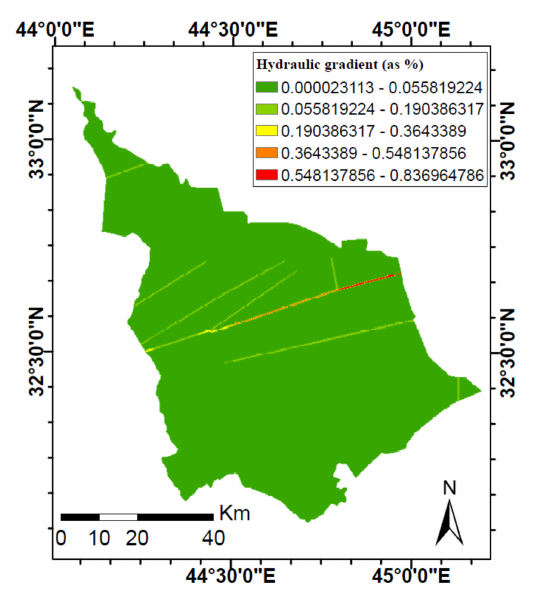
Figure 13. Groundwater hydraulic gradient in the Babylon study area.